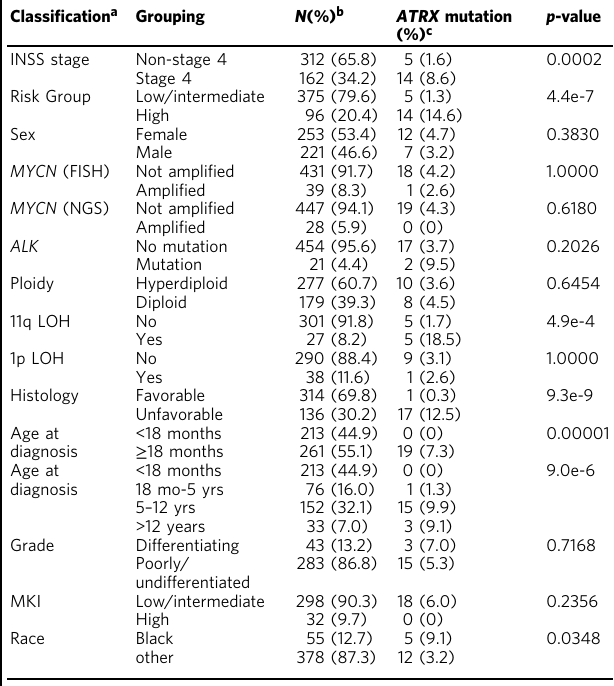
Table 1 Distribution of ATRX mutations in